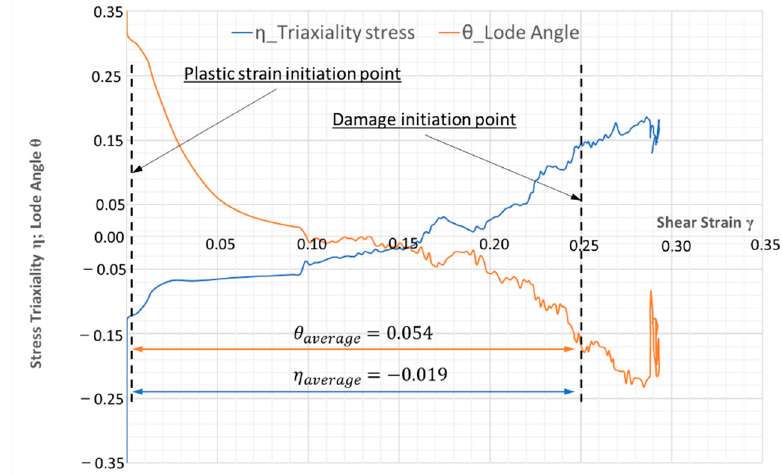
Figure 9. Evolution of average stress triaxiality η , Lode angle parameter θ of the whole shear zone as a function of nominal shear strain.